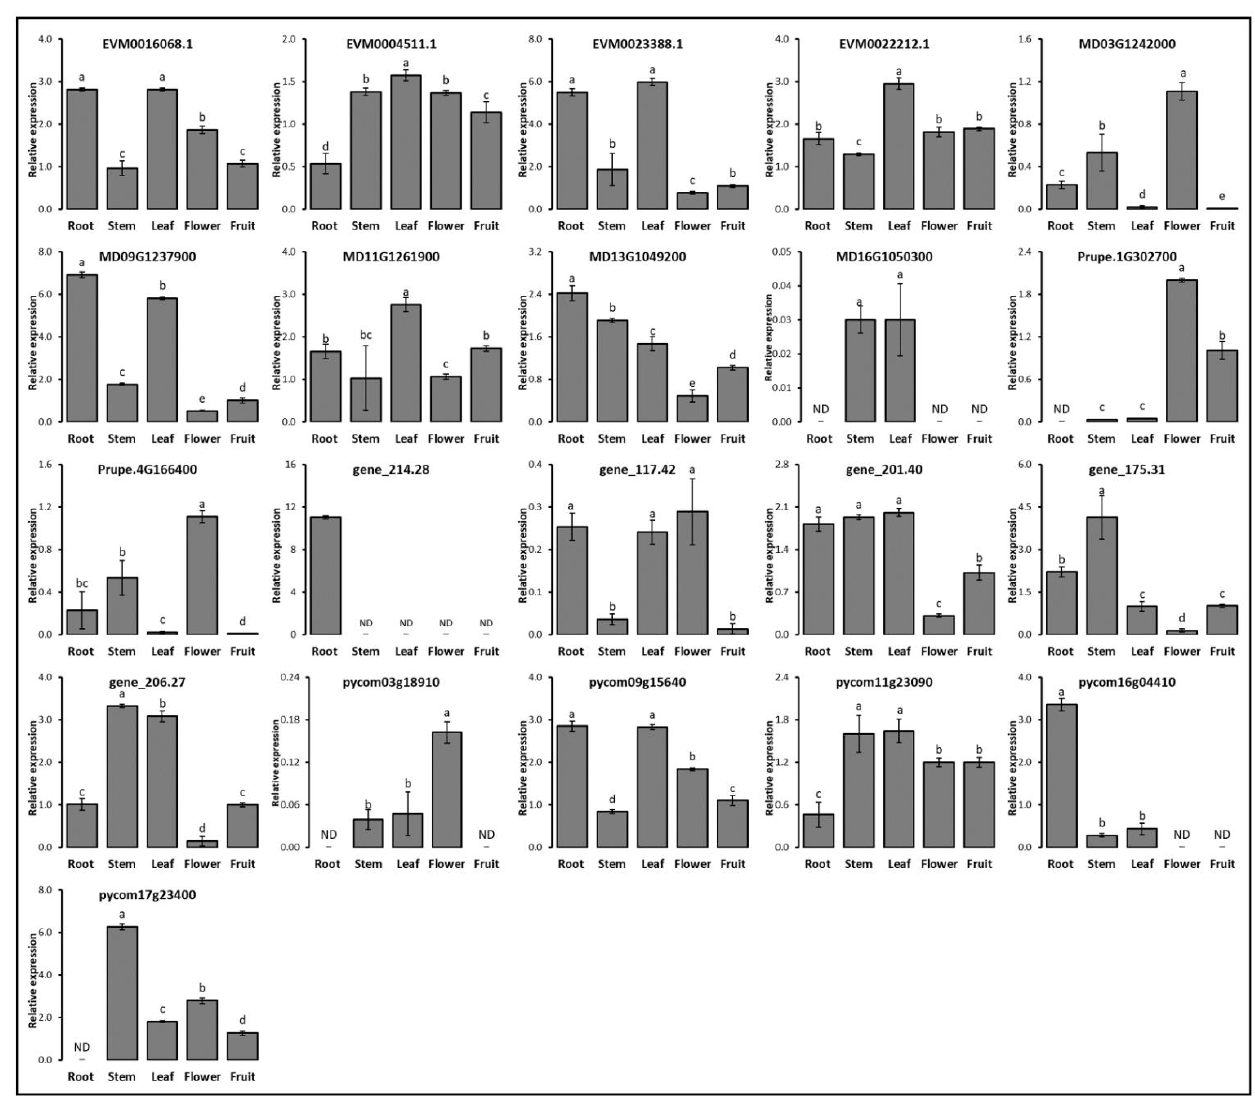
Figure 6. Relative expressions of PEPCs in different tissues of five Rosaceae species i.e., loquat, apple, peach, strawberry, and pear. Same letters indicate non-significant difference among treatments according to Fisher’s least significant difference (LSD) test, when p ≤ 0.05. Vertical bars indicate mean ± standard error (3 biological and 3 technical replicates). ND — not detected.